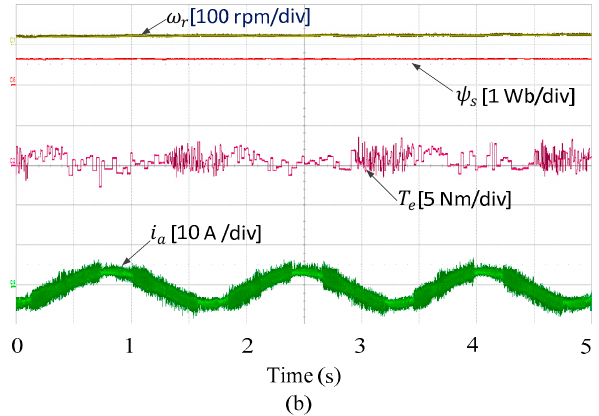
Figure 10. Experimental results of low-speed performance for CFTR-DTC with ( a ) single carrier and ( b ) interleaving carriers.